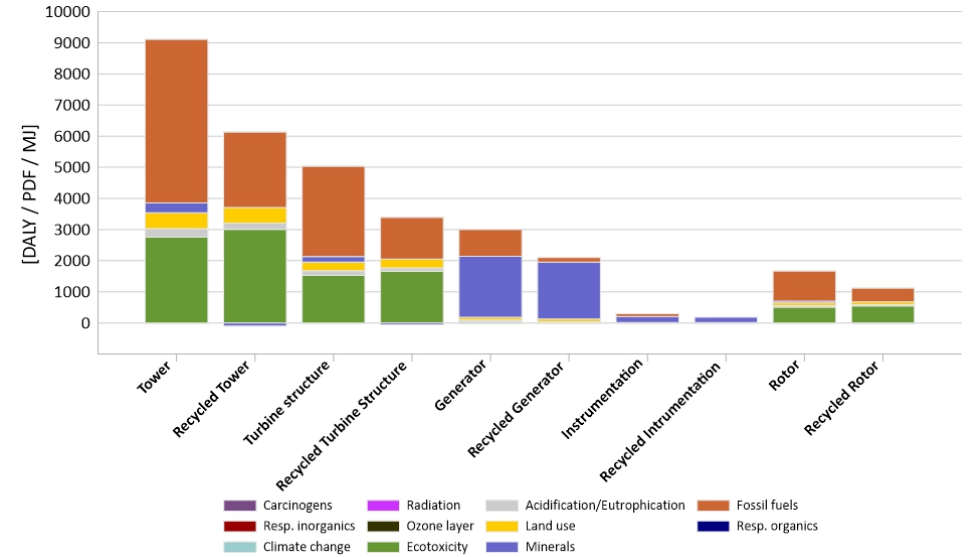
Figure 5. Results of characterization of environmental impact occurring during the life cycle of an innovative wind power plant elements, comparison of results with and without recycling. Table 2. Results of characterization of environmental consequences occurring in particular stages of the life cycle of an innovative 15 kW wind power plant, including categories of impacts without recycling.